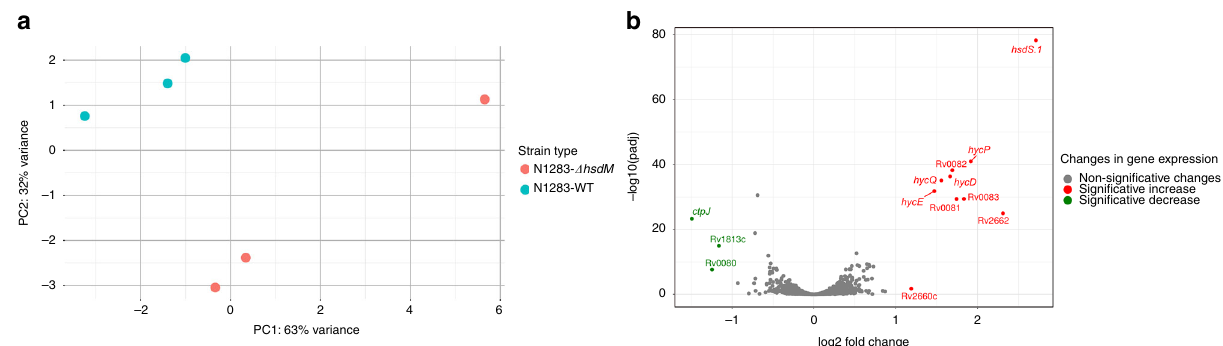
Fig. 6 Gene expression differences due to an hsdM deletion. a Overall transcriptomic pro fi les of the wild-type versus the Δ hsdM strains. b Volcano-plot of the gene expression differences of the wild-type versus de mutant strains. A small numbers of genes showed differential expression (3 downregulated and 10